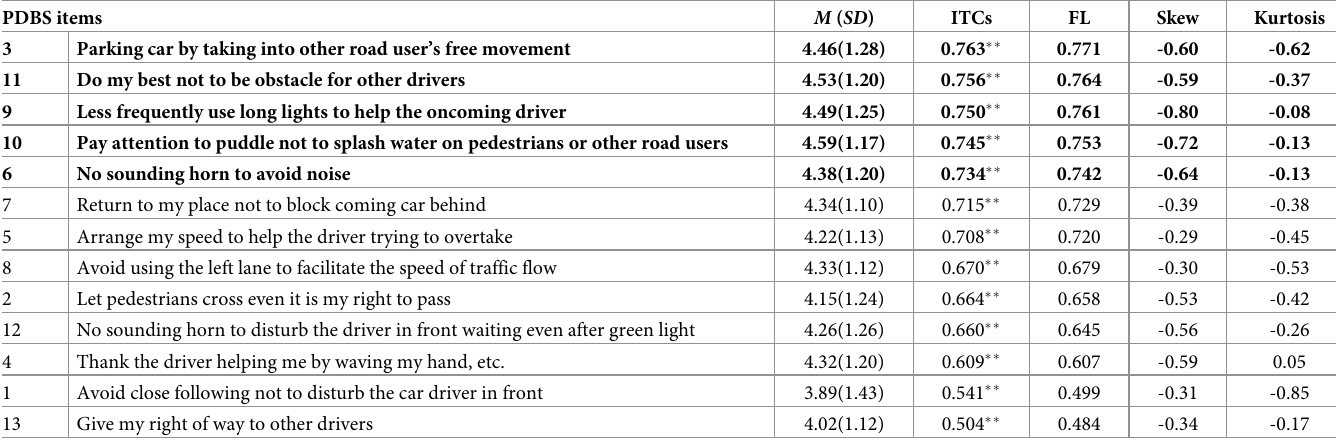
Table 2. The descriptive statistics of the PDBS items and subscales ( N = 421).